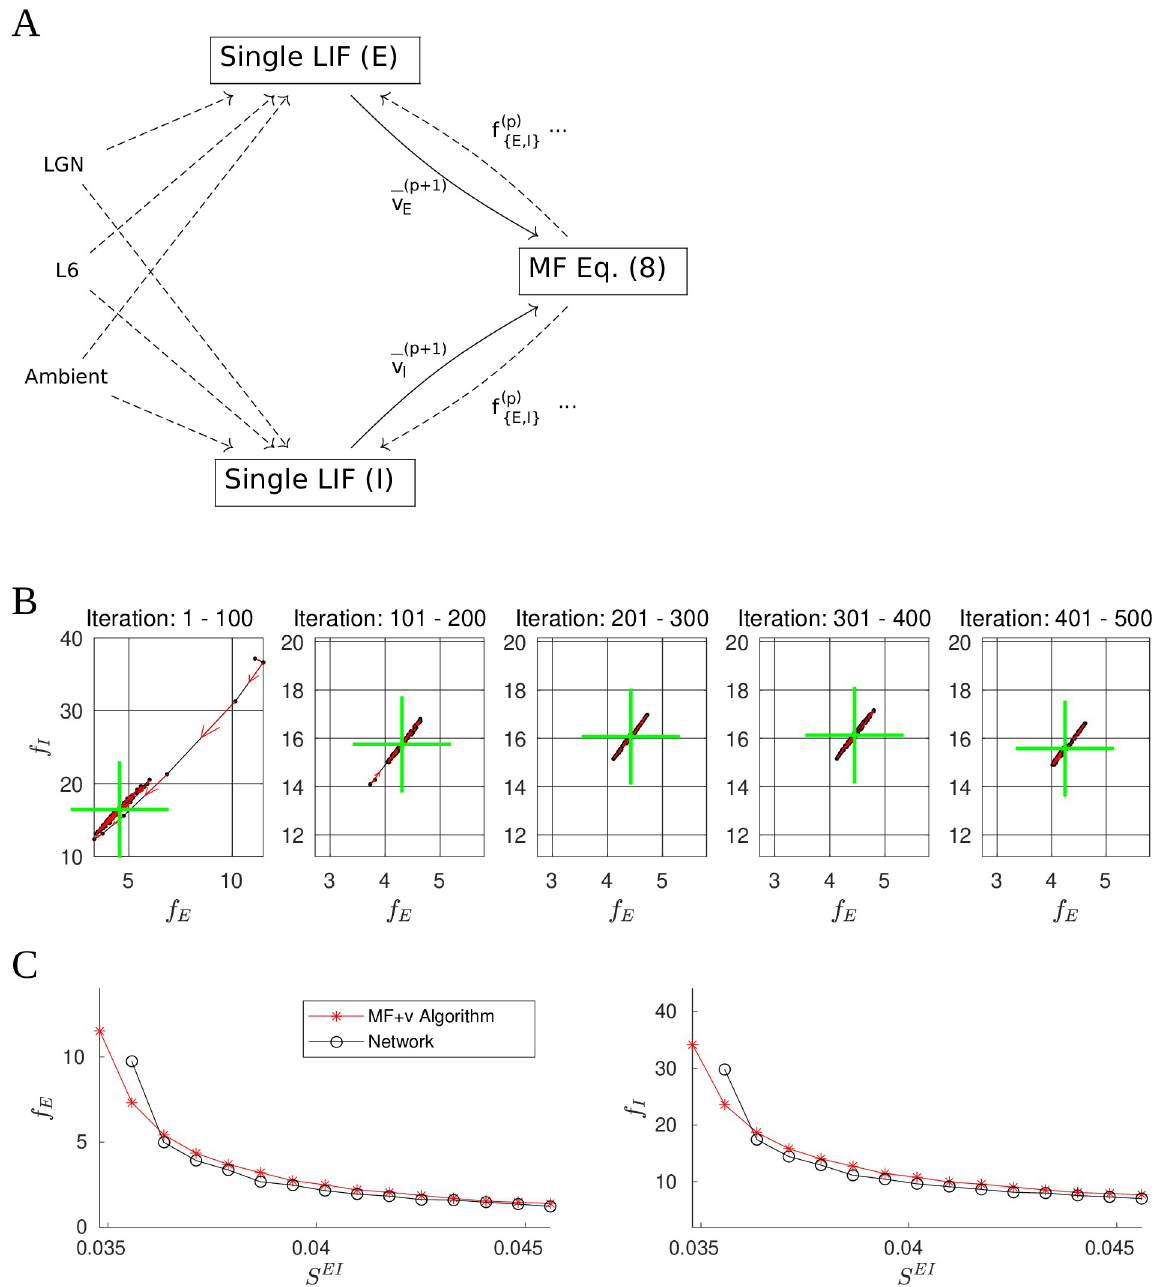
Fig 9. The MF+v algorithm. A. Schematic of the algorithm. We begin by choosing initial values f 0 of LIF neurons for 20 seconds (biological time). The resulting membrane voltages are then fed into the MF Eq (8), which gives us firing rates for the next iteration. This is repeated until certain convergence criteria are met (see text). In the above, all dashed lines are modeled by Poisson processes. B. 500 training iterations of the MF+v. The means of every 100 iterations are indicated by green crosses, stability properties of which are quite evident. C. Comparison of network (black) and MF+v computed (red) firing rates.